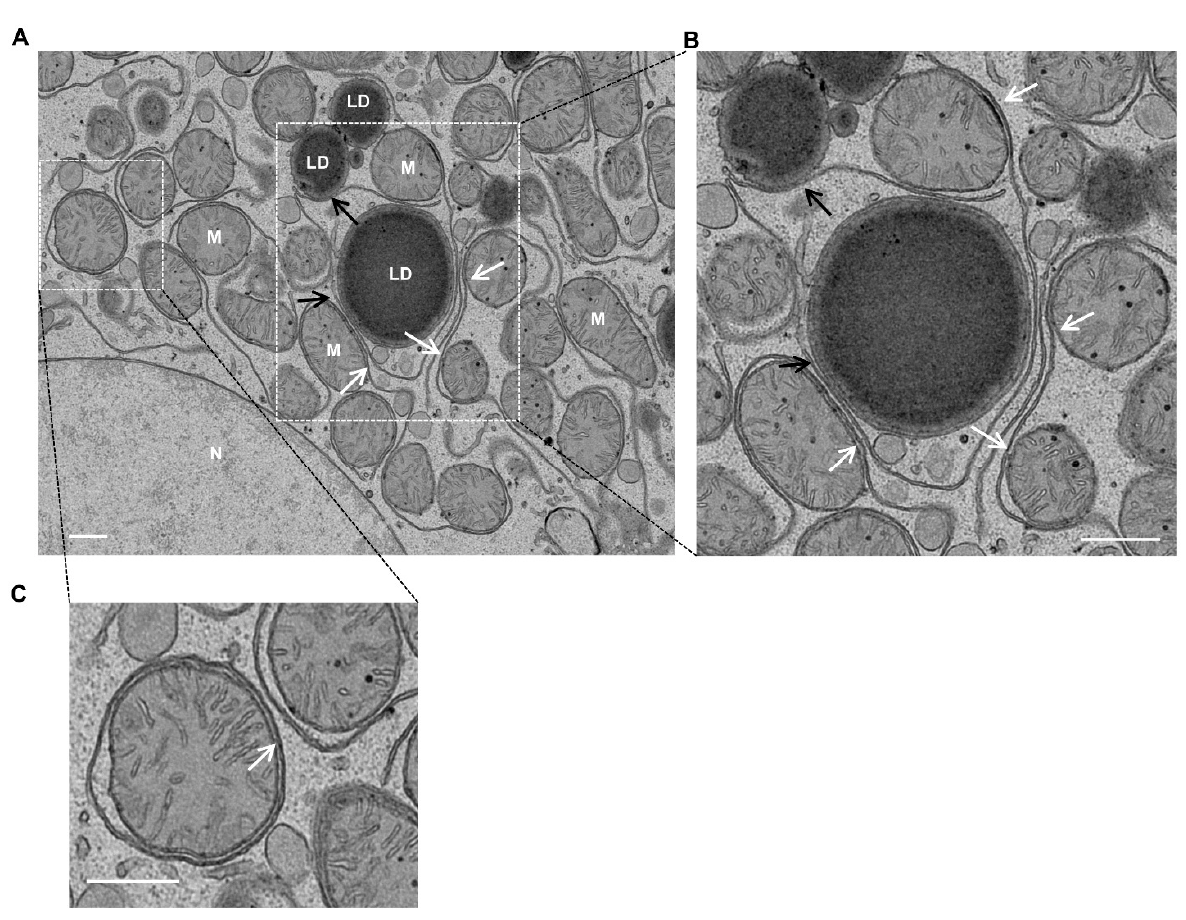
Figure 1. Ultrastructure illustrations of membrane contacts in hepatocytes. Primary mouse hepatocytes were cultured for 24 h, then analyzed by EM. ( A ) Representative EM image of a primary cultured hepatocyte. ( B , C ) Enlarged images from the boxed areas in A. White arrows denote mitochondria–ER contact and black arrows denote ER–LD contact. LD: lipid droplet; M: mitochondria; N: nucleus. All of the EM imaging data in this manuscript are from the authors’ lab and have not been previously published. Bar: 500 nm.